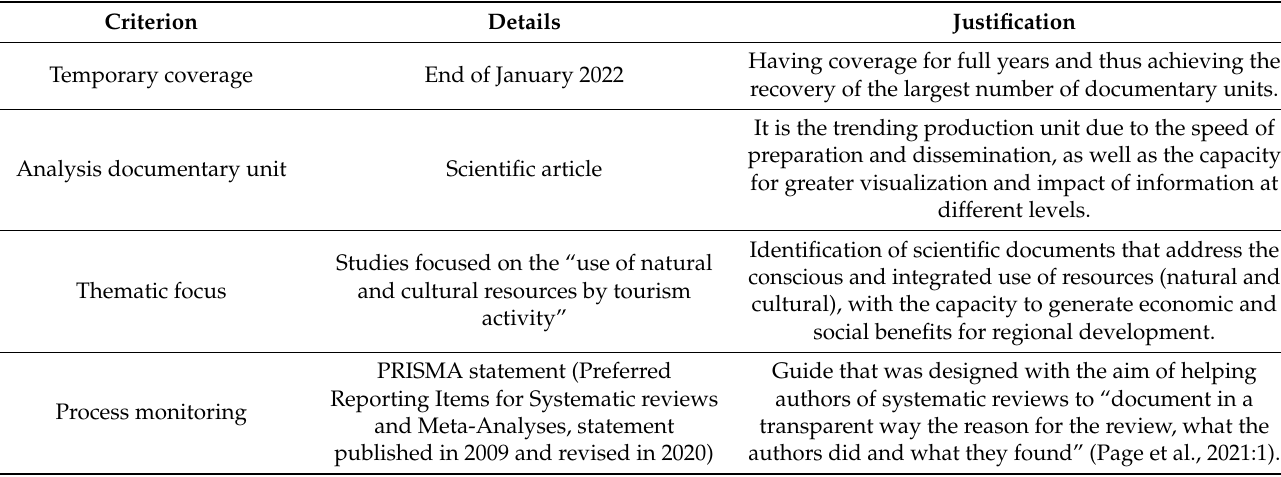
Table 1. Details of the search criteria.